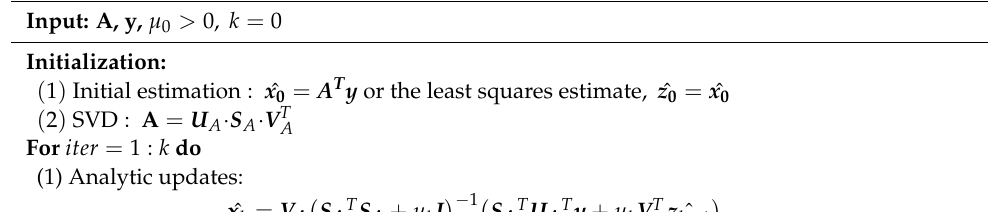
Algorithm 1. DCNNs based end-to-end unrolled network for IR